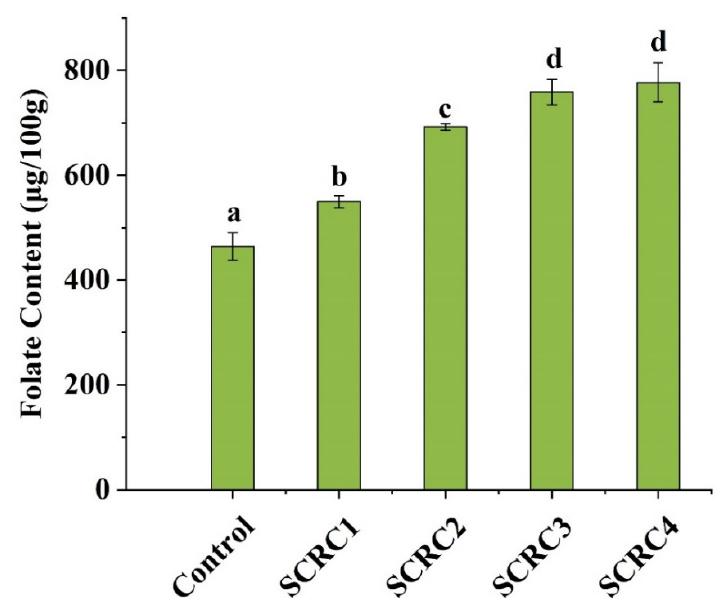
Figure 2. Content of folate in cakes with SRC addition. Bars with different letters in each fraction are significantly different ( p < 0.05).